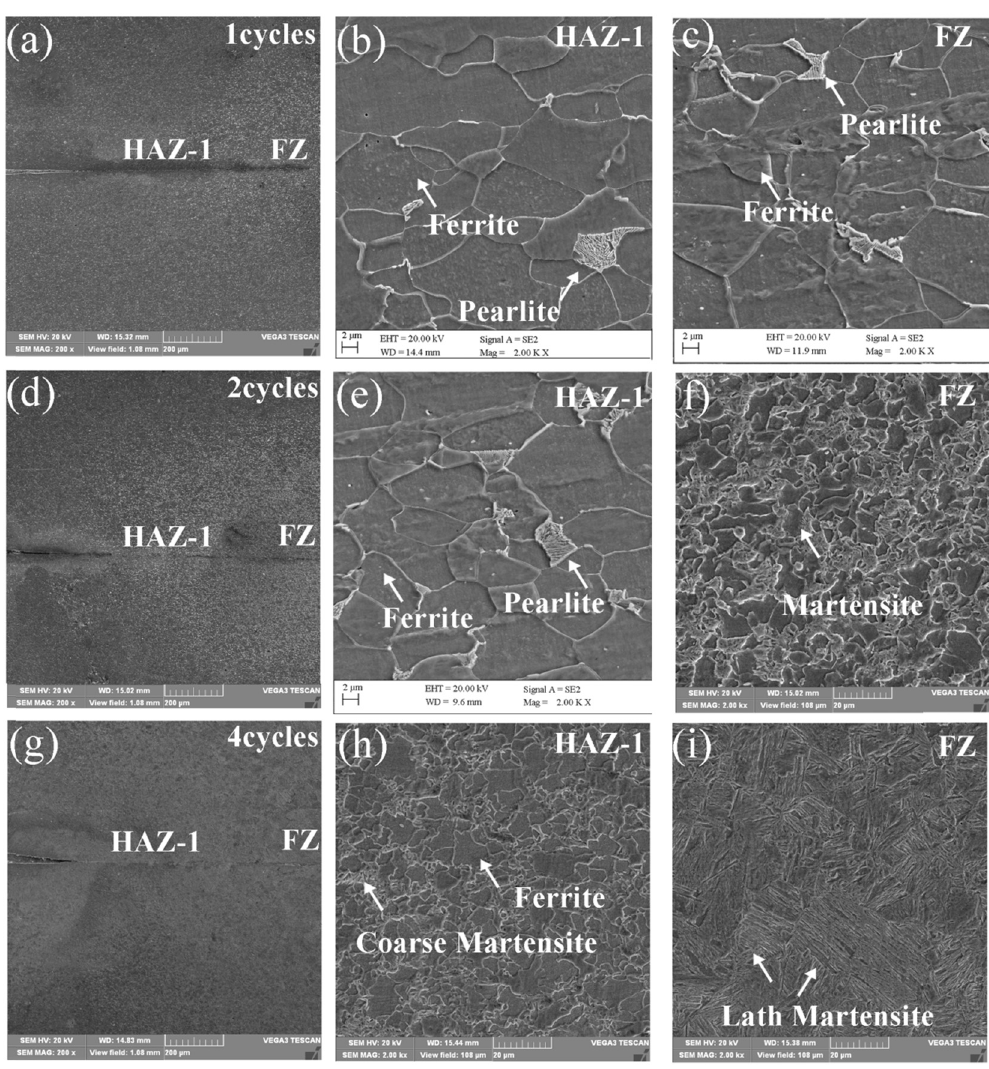
Figure 7: SEM images of joints under di ff erent welding times: ( a ) 1 cycles, ( b ) 1 cycles - HAZ - 1, ( c ) 1 cycles - FZ, ( d ) 2 cycles, ( e ) 2 cycles - HAZ - 1, (